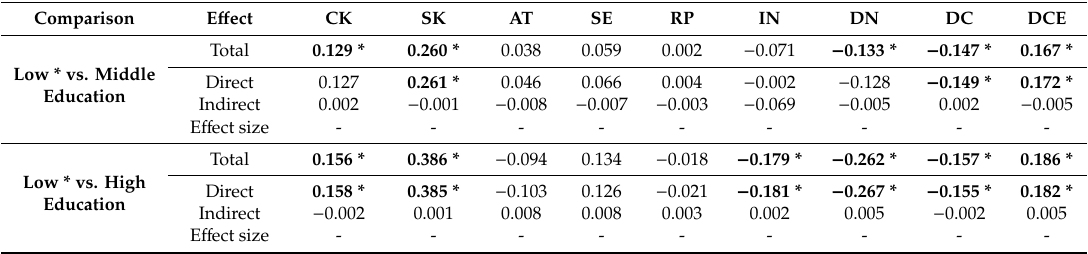
Table 5. Standardized total, direct and total indirect: mediator Communication